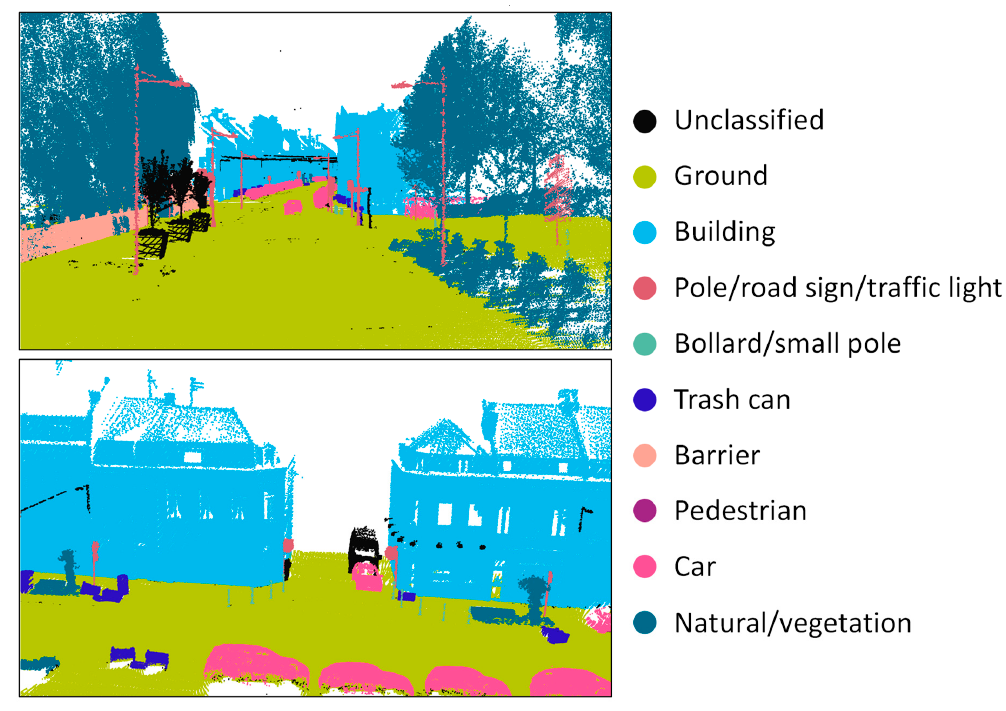
Figure 8. Example of benchmark MLS datasets (Paris-Lille-3D).